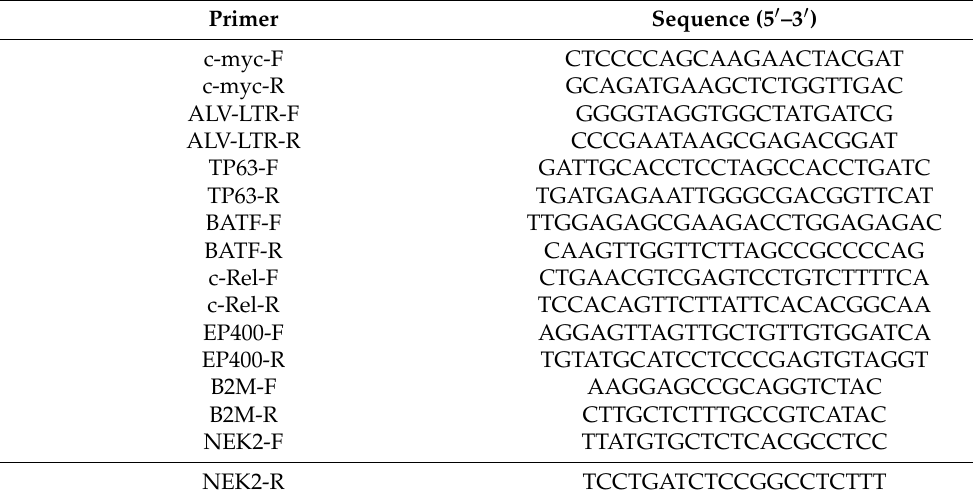
Table 1. Primers used in PCR and